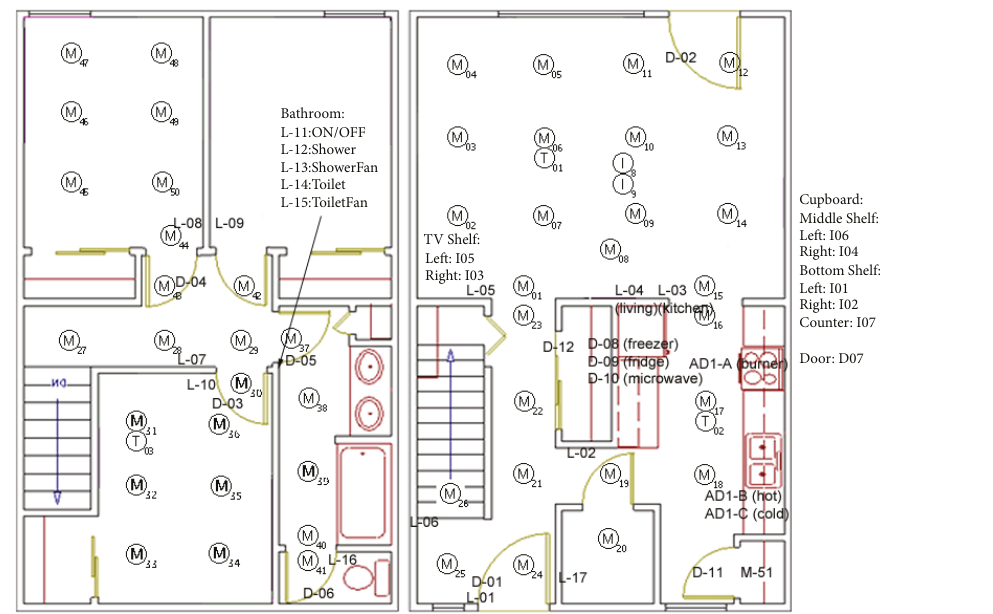
Figure 4: Floor plan with sensor locations used in this study. M indicates motion sensors and T indicates temperature sensors [6].